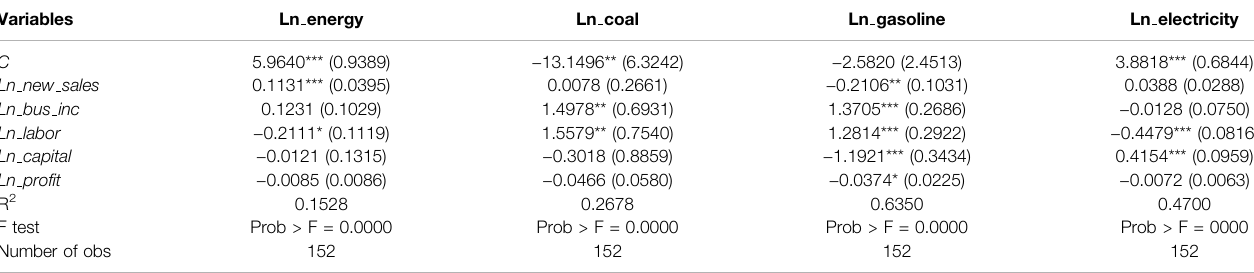
TABLE 3 | Empirical test results (1). Variables